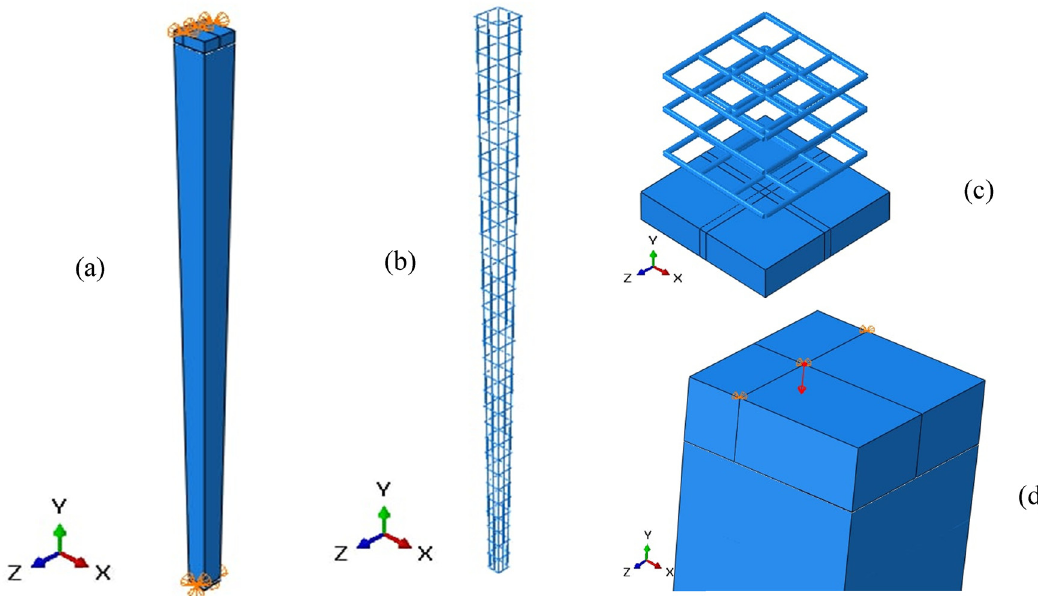
Figure 8: ( a ) Whole model, ( b ) reinforcement, ( c ) bearing plate and wire mesh, and ( d ) application of the eccentric load to the